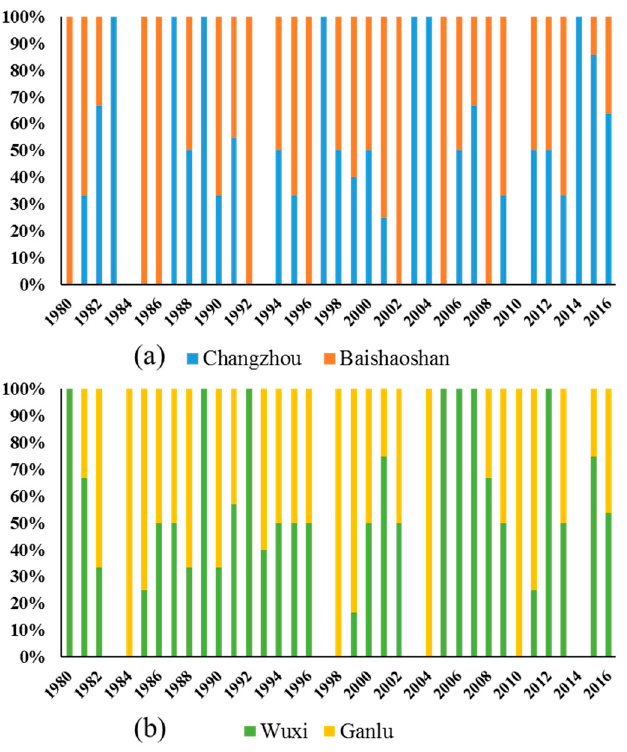
Figure 6. The occurrence of the high intensity in the highly-urbanized stations and the lowly-urbanized stations from 1980 to 2016. The results of ( a ) Changzhou station and Baishaoshan station and ( b ) Wuxi station and Ganlu station.